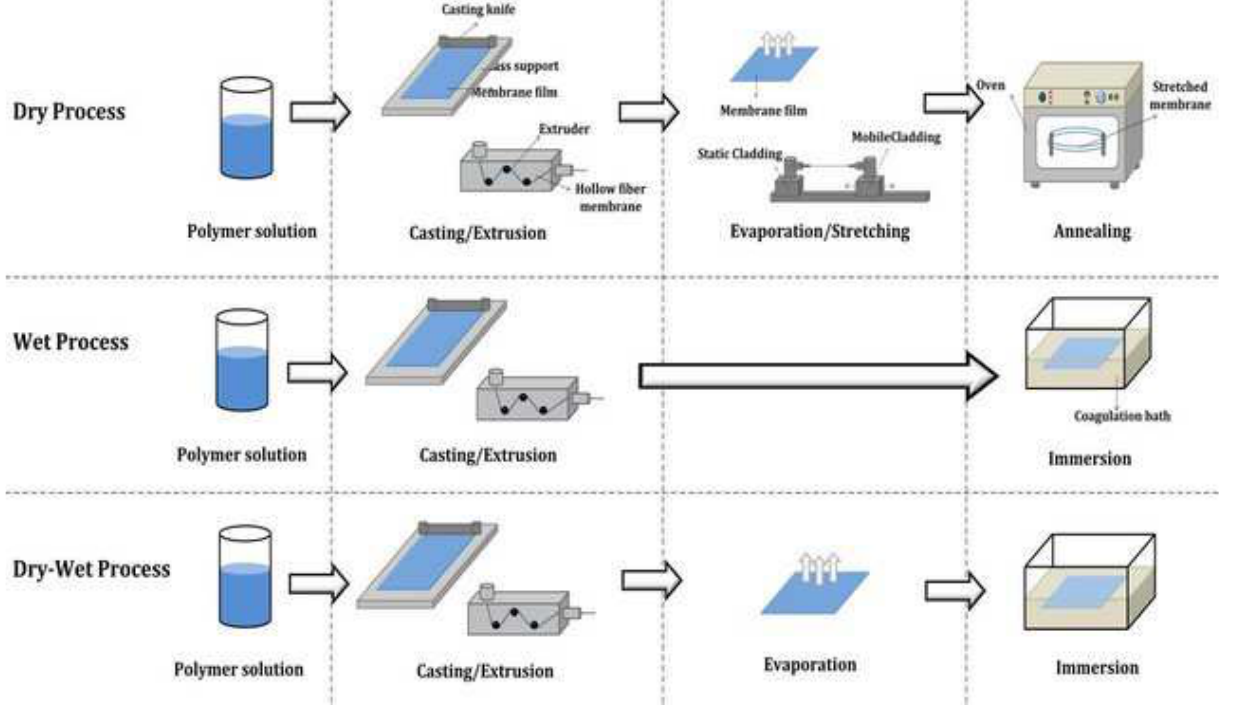
Figure 3. Diagrammatic representation of membrane fabrication by phase inversion process. Reproduced with permission from [108]. Copyright 2019 Penerbit UTM Press.